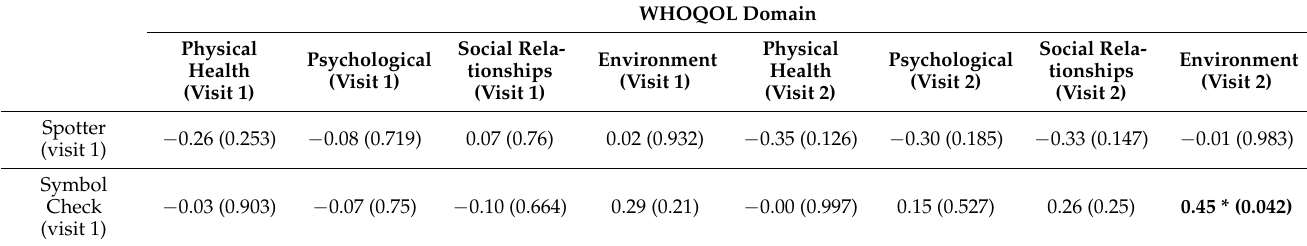
Table 3. Correlations for THINC-it cognitive measures and for the quality of life scores (WHOQOL- BREF domains) from visit 1 and visit 2 (Pearson’s r, p -values in